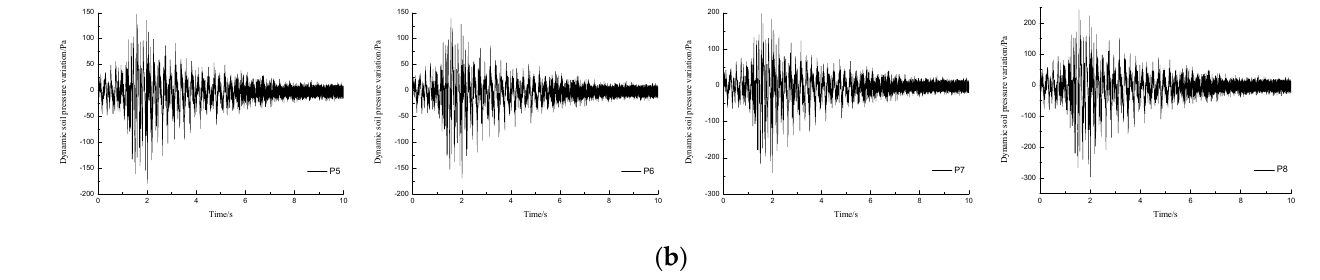
Figure 6. Time-histories of ( a ) acceleration and ( b ) dynamic soil pressure variation in response to Minxian wave with input peak ground acceleration (PGA) of a = 0.1 g.